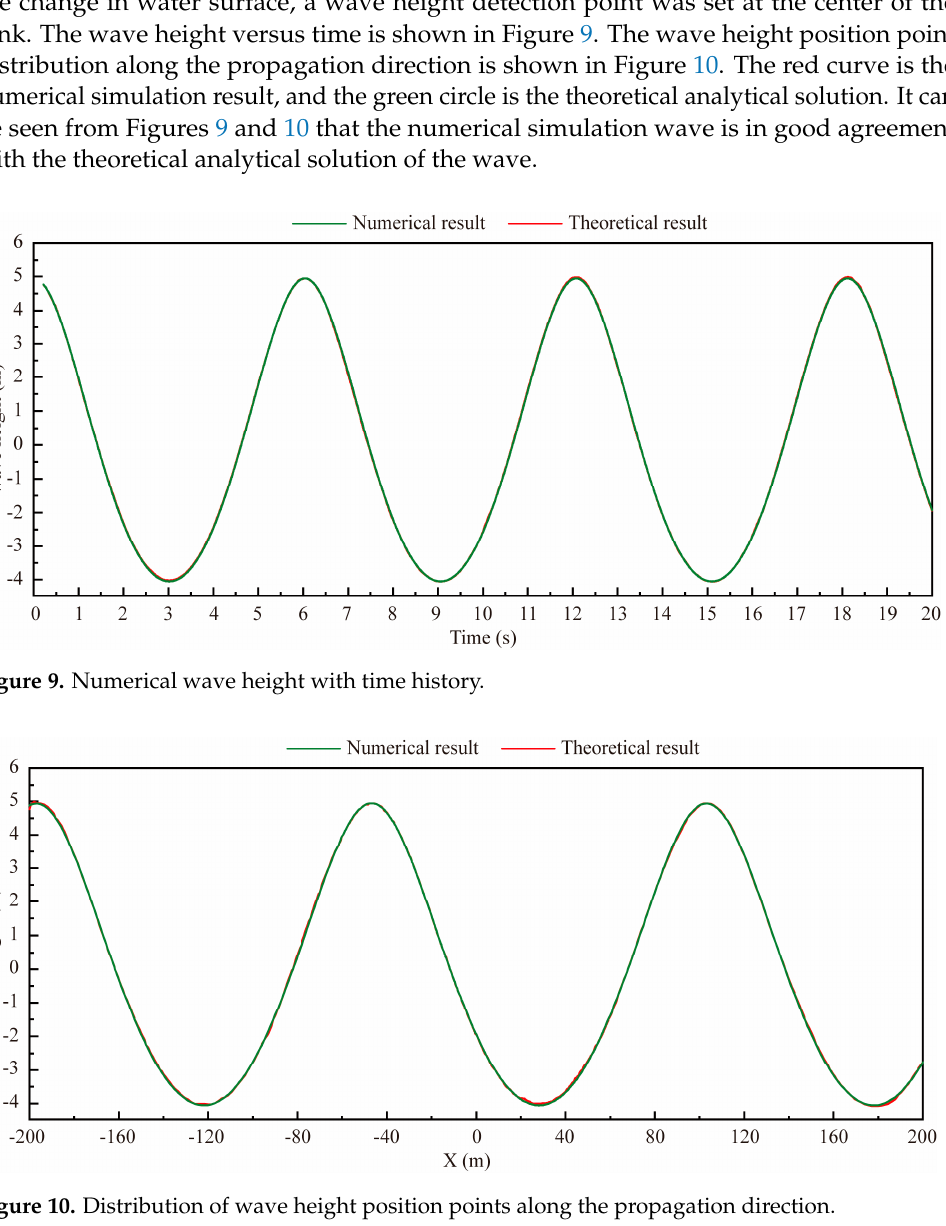
Figure 11. The waveform of numerical wave propagation after 20 s.